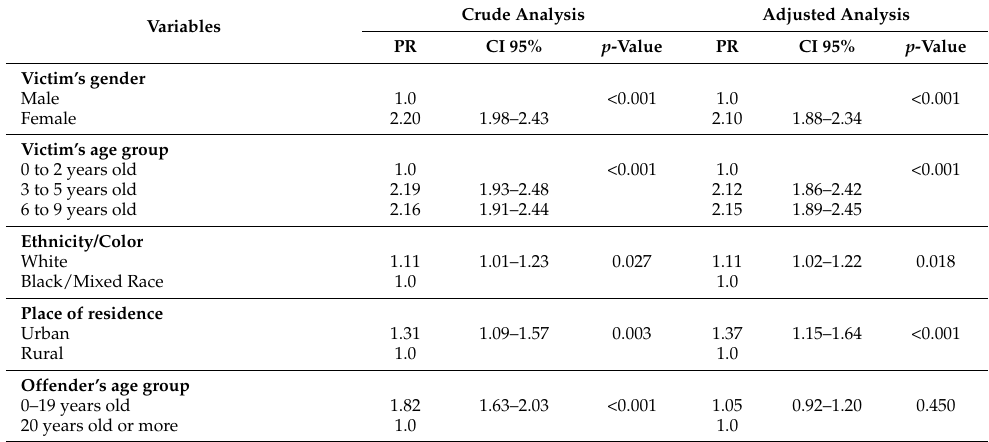
Table 3. Crude and adjusted analysis of the effects of the characteristics of the victim, the offender and the offense with the sexual violence perpetrated against children. Esp í rito Santo, 2011 to